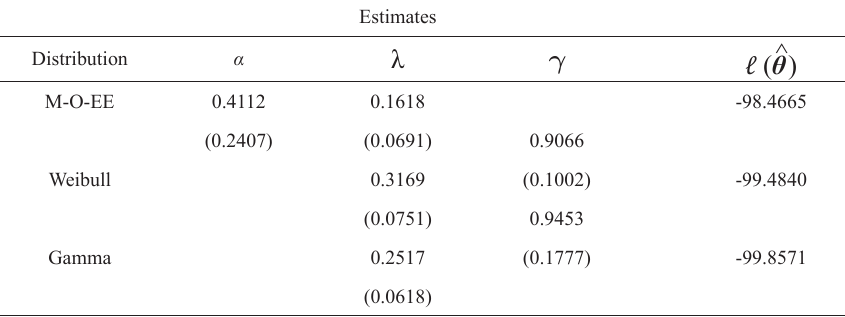
MLEs of the model parameters and log-likelihood functions. Estimates